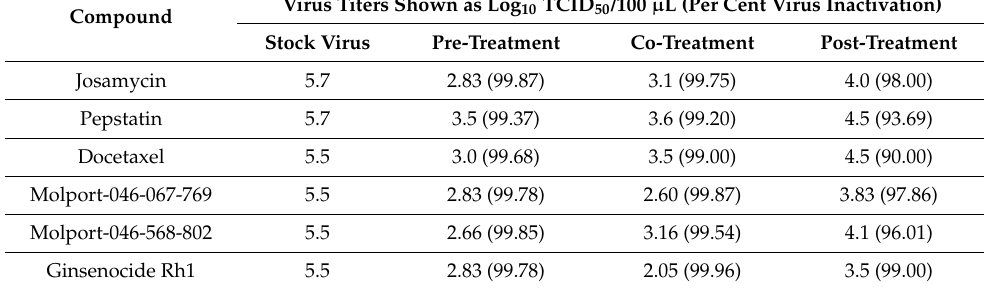
Table 7. The effect of 50ug/mL of the six compounds on human coronavirus